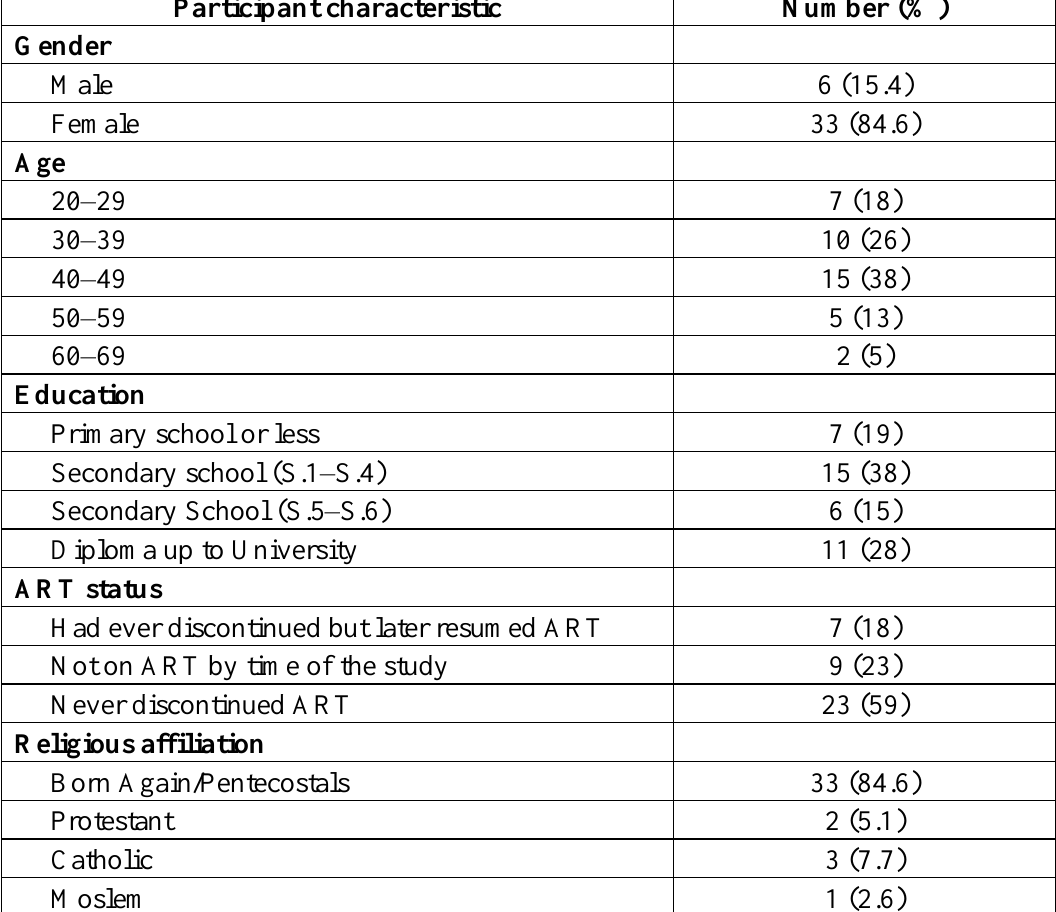
Table 1. Study Participants‘ characteristics (n =